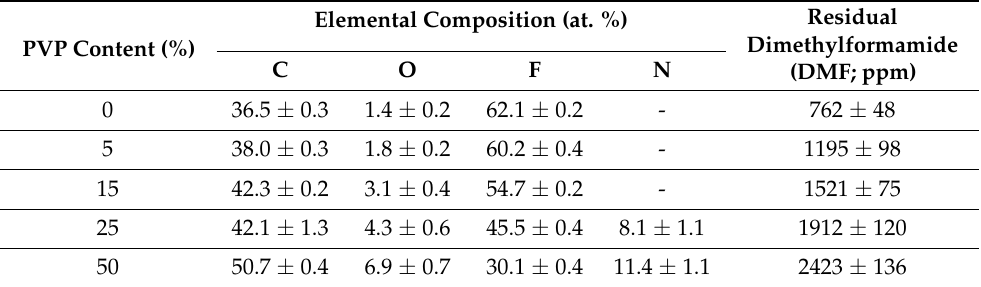
Table 2. Elemental compositions of vinylidene fluoride/tetrafluoroethylene (VDF–TeFE) membranes with different PVP contents.